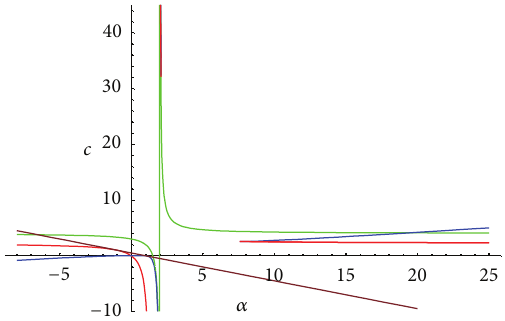
Figure 4: Bifurcation curves of critical points.